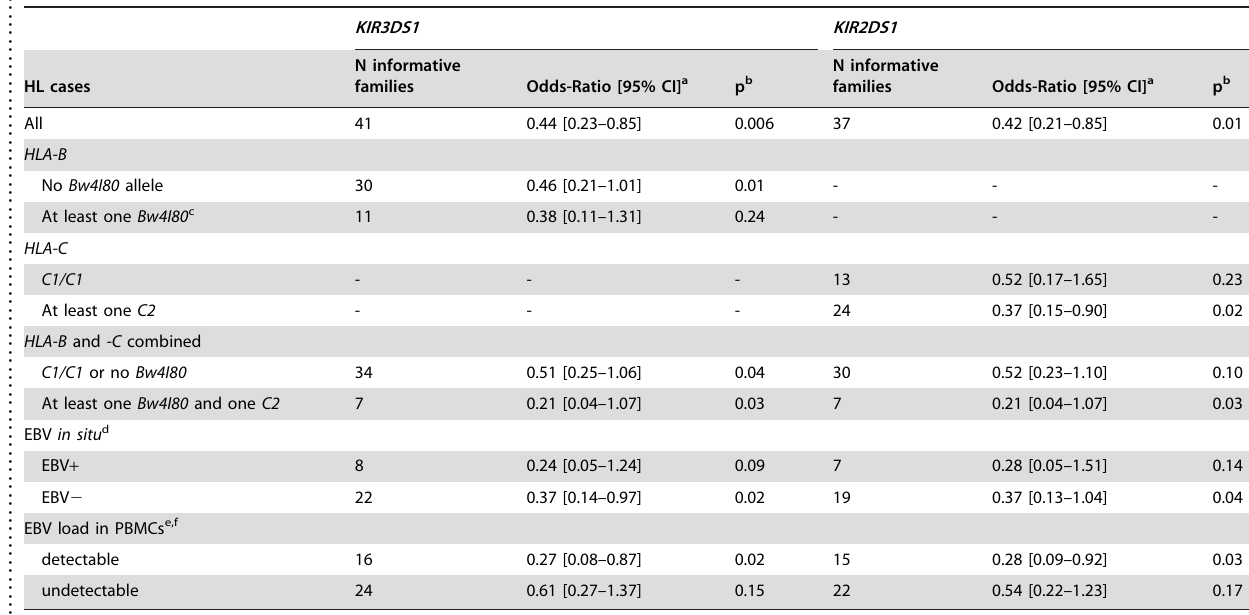
Table 4. Effect of KIR3DS1 and KIR2DS1 stratified on HL patients characteristics .. ... .... ... ... .... ... ... .... ... ... .... ... ... .... ... ... .... ... ... .... ... ... .... ... ... .... ... ... .... ... ... .... ... ... .... ... ... .... ... ... .... ... ... . KIR3DS1 KIR2DS1